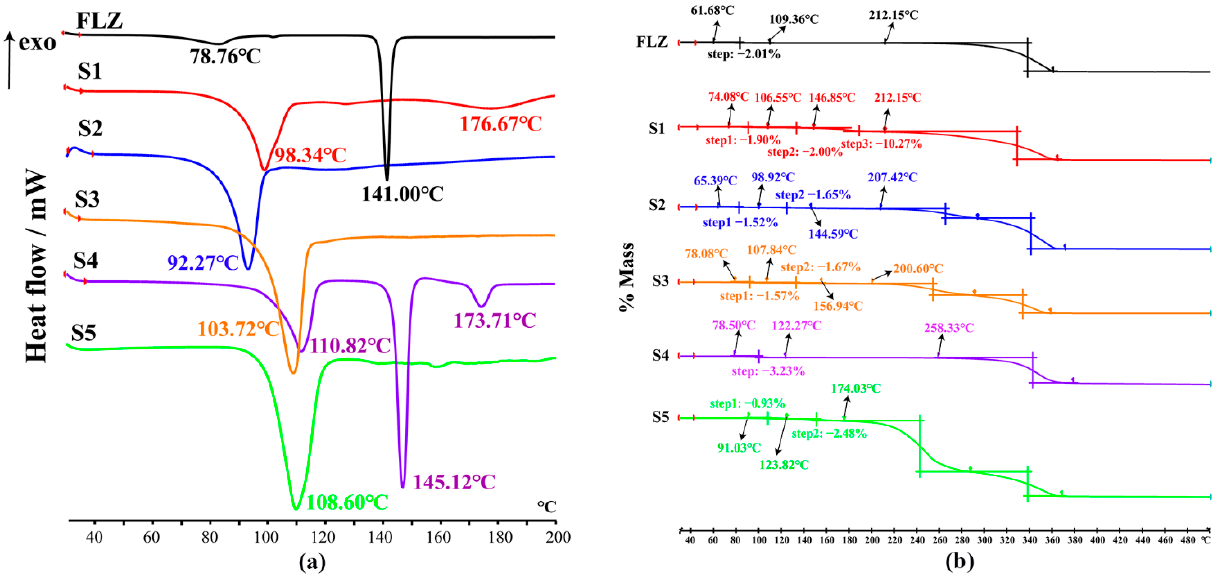
Figure 9. Thermal analysis curve for FLZ raw material, (S1) FLZ − 24DHB − H 2 O (1:0.5:1), (S2) FLZ − 34DHB − H 2 O (1:0.5:1), (S3) FLZ − 34DHB − H 2 O (1:1:1), (S4) FLZ − 35DHB − H 2 O (1:1:1), (S5) FLZ − 345THB − H 2 O (1:1:1), indicating their dehydration, melting and decomposition events. ( a ) DSC thermograms, ( b ) TG